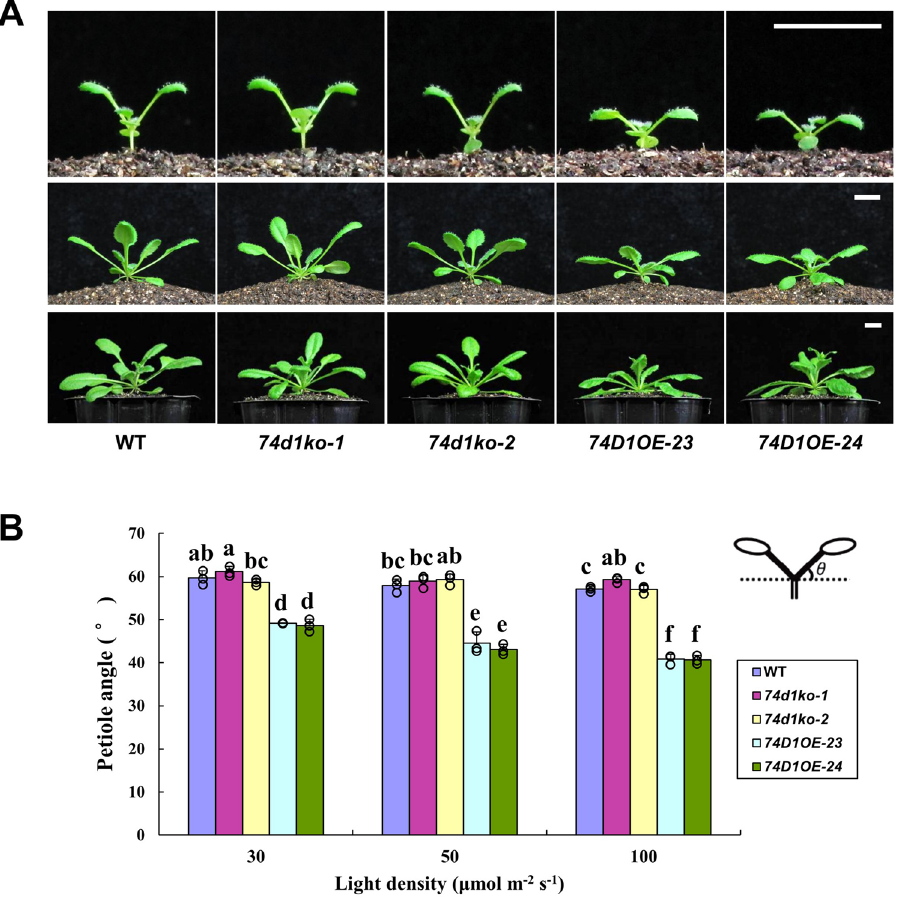
Figure 6. Leaf positioning phenotype of the transgenic lines. ( A ) Plants grown in soil for 2, 3 and 4 weeks, respectively. Scale bar = 1 cm. ( B ) Petiole angle of 2-week-old seedlings grown under different light intensities. At least 15 plants were tested within one replicate. The statistical significance of the difference was confirmed by ANOVA at α = 0.05 level. Error bars indicate SD from triplicate